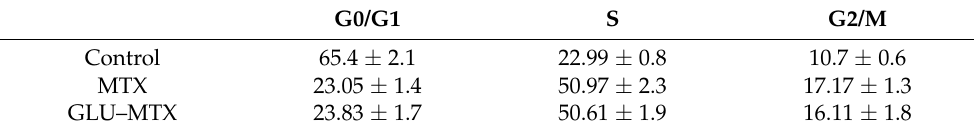
Figure 5. The effect of MTX and GLU–MTX on MFC-7 cell cycle progression. Table 1. Cell cycle progression data presented as mean ± standard deviation (SD).